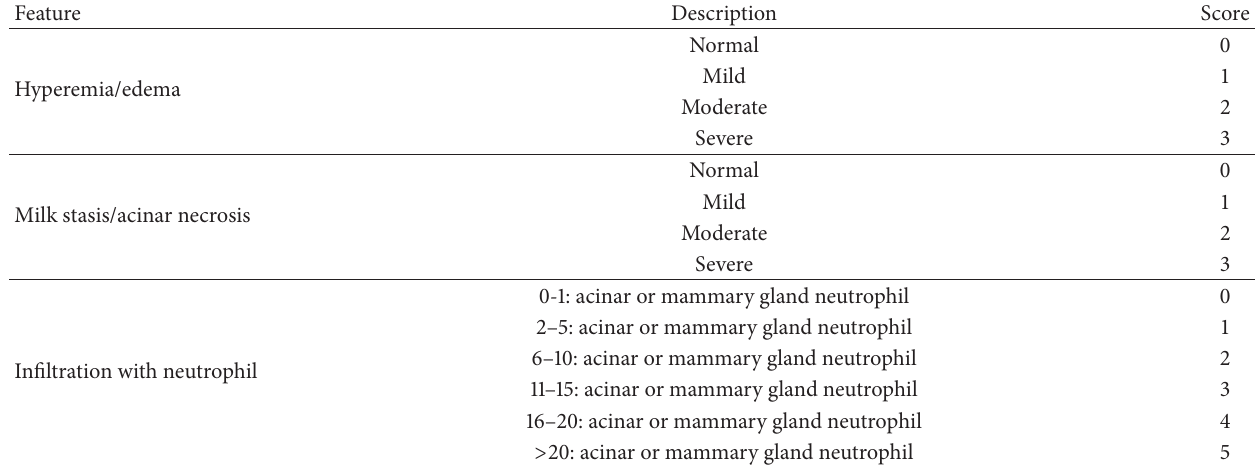
Table 1: Histopathologic scoring